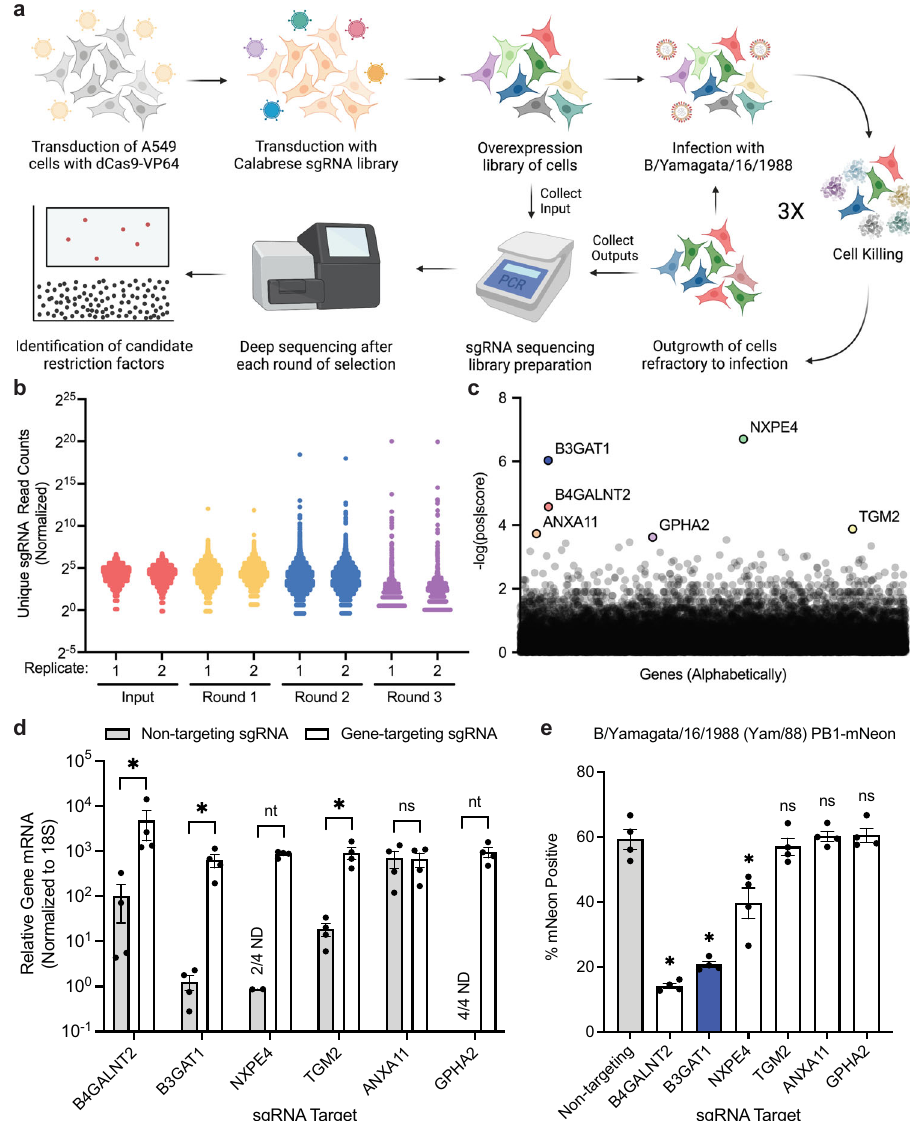
Fig. 1 | A genome-wide CRISPR activation screen identi fi es restriction factors for in fl uenza B virus. a Schematic of the CRISPR activation screening approach used.sgRNA = single guideRNA. b sgRNAread counts detectedforeach round of infection by B/Yamagata/16/1988 (Yam/88) during the screen. Each point repre- sents a unique sgRNA for each independent screen replicate and sgRNAs not detectedareomittedfromthegraph. c Rankedscoresforupregulatedgenesafter three rounds of Yam/88 infection. The top six ranked genes are labeled. d ExpressionoftheindicatedgenesinA549dCas9-VP64cellsafteractivationwith the most enriched sgRNAs from the screen or a non-targeting control sgRNA, measured using qRT-PCR (mean with SEM, N =4 experiments, B4GALNT2